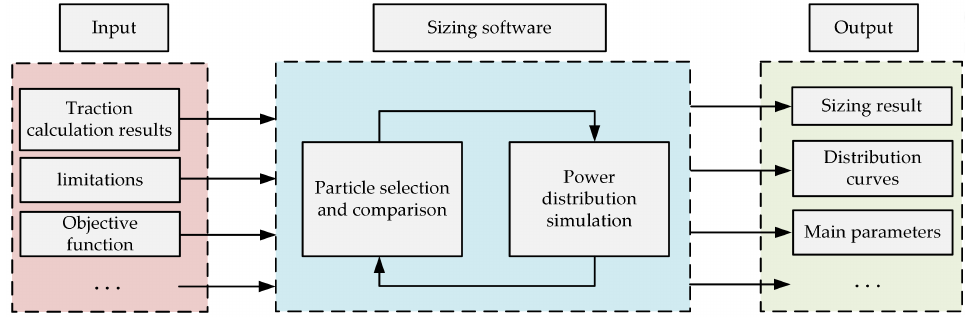
Figure 6. Constitutions of sizing optimization program.